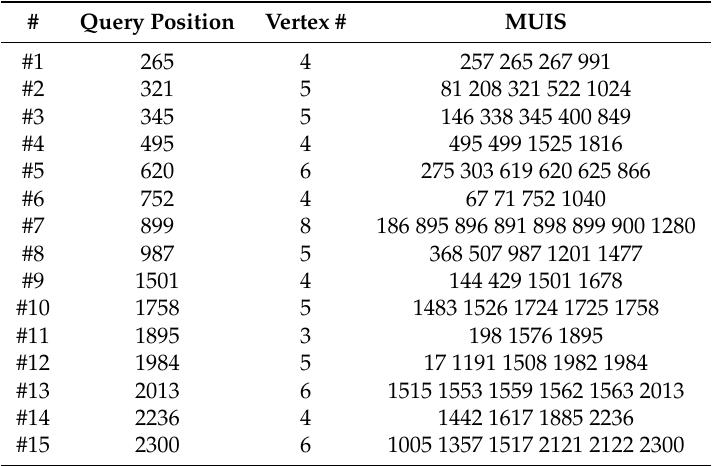
Table 1. Experimental results on the